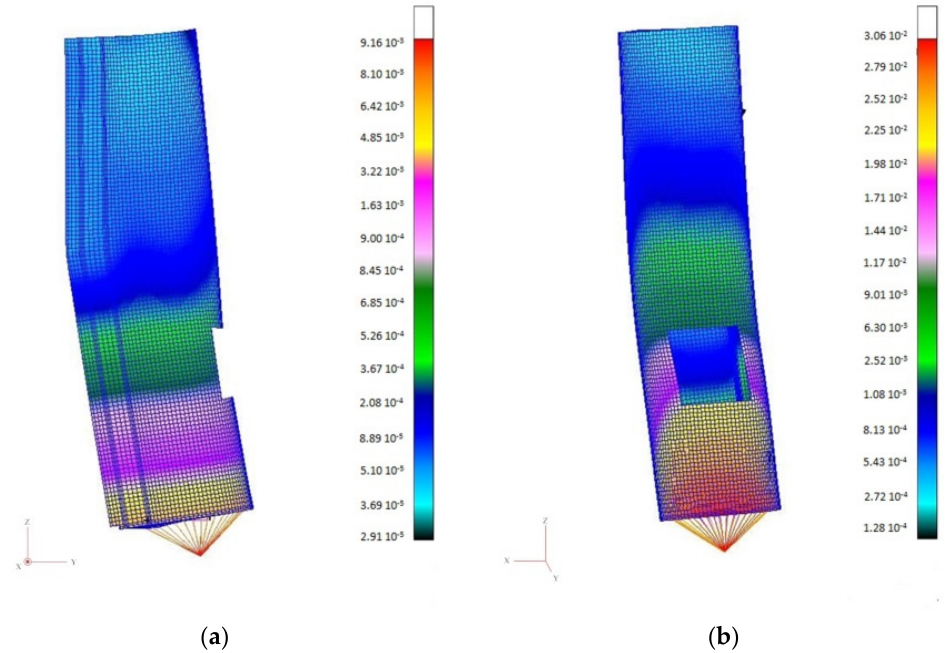
Figure 4. The Finite Element (FE) analysis results (strain ‐ tensors) performed on the Carbon Fiber Reinforced Polymers (CFRP) beam with the embedded fiber Bragg grating (FBG) sensors applying a static load (2000 N) on the x ( a ) and the y ( b ) axis.